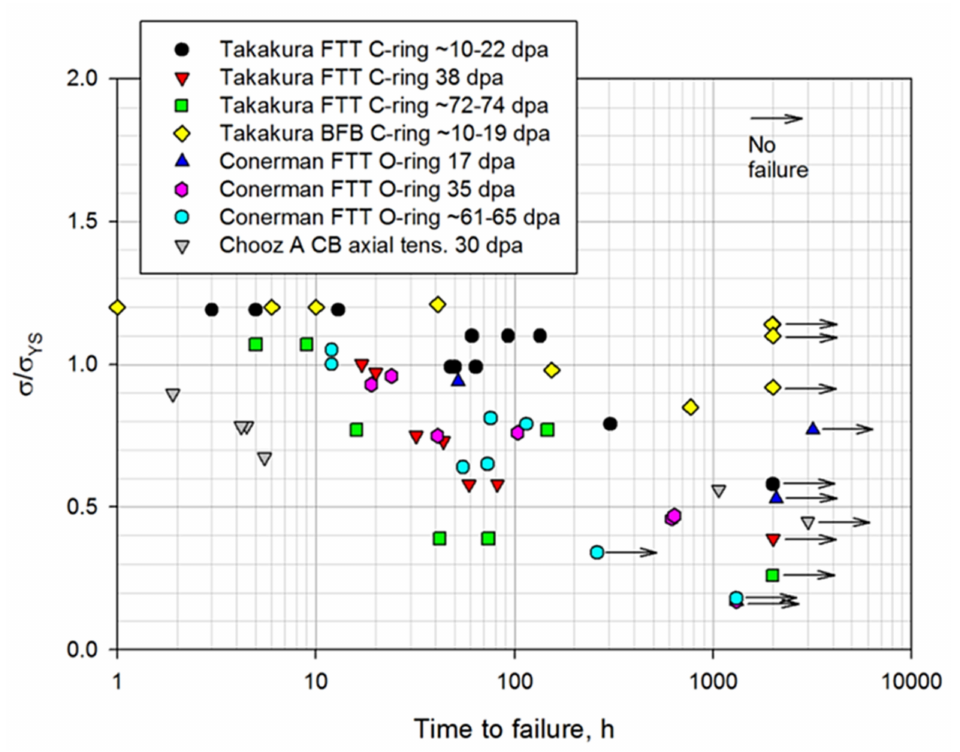
Figure 3. Collected data on C-ring and O-ring PWR IASCC tests (1000–1200 ppm B (as H 3 BO 3 ), 2–2.2 ppm Li (as LiOH) and ~30 cc/kg dissolved H 2 ). Acronyms: FTT = flux thimble tube, BFB =